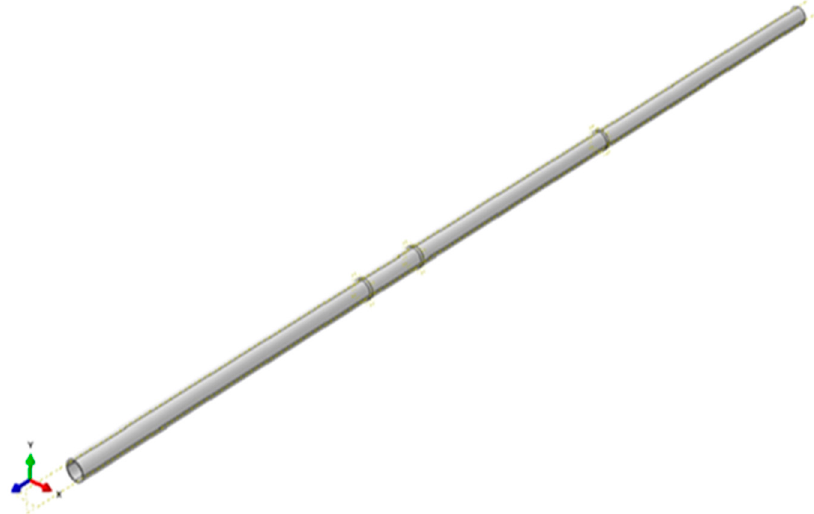
Figure 8. Tunnel finite element simulation diagram.